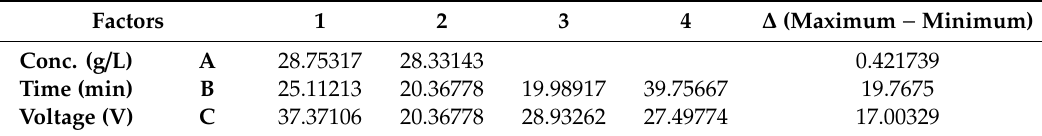
Table 7. S / N response for the standard